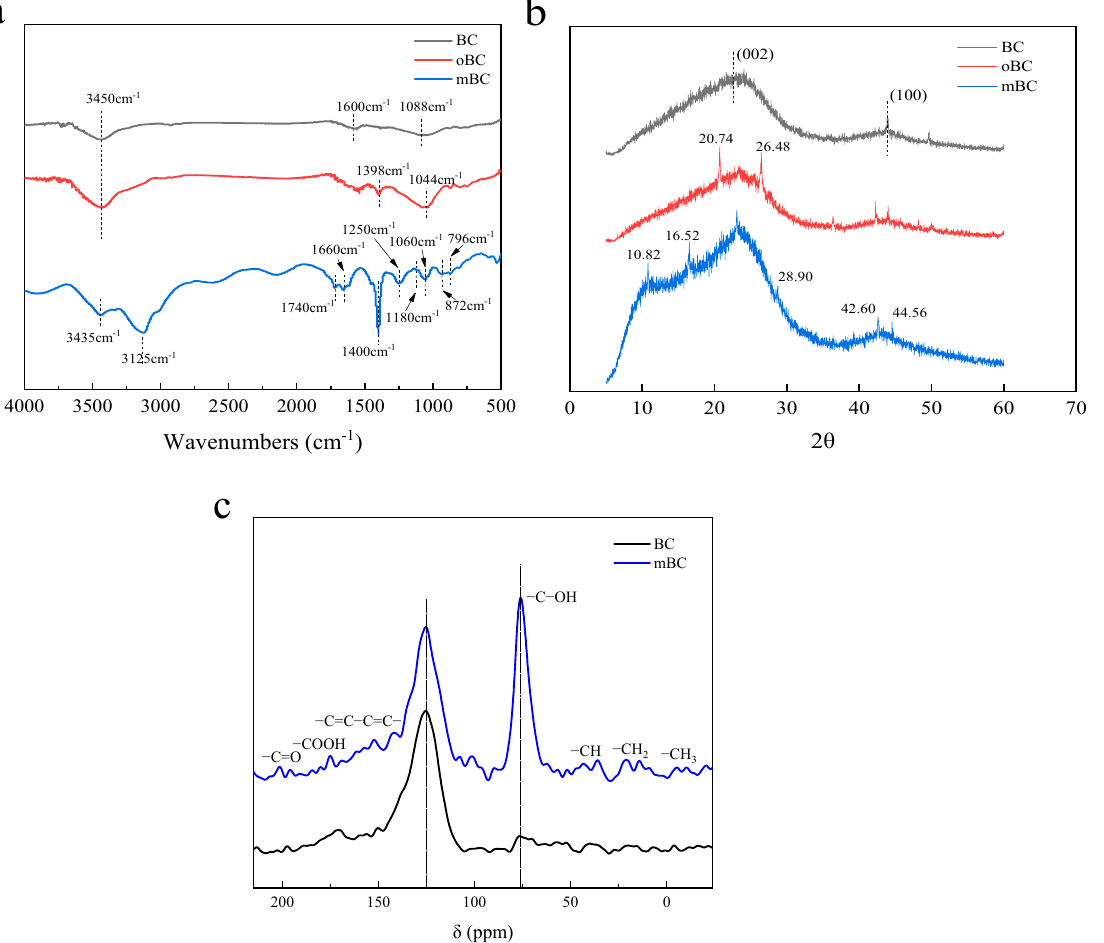
Figure 3. FTIR( a ), XRD( b ) and 13 C-NMR( c ) spectra of BC, oBC and mBC. Figure 3. FTIR ( a ), XRD ( b ) and 13 C-NMR ( c ) spectra of BC, oBC and mBC. XRD data were analyzed to further confirm the differences between virgin BC and Unlike virgin BC, the oxide BC gained obvious peaks at 2 θ = 20.74° and 26.48°, and mBC. Virgin BC did not claim any clear and definite diffraction peaks, as shown in Figure 3b, mBC had a good deal of crystal structures, for instance, peaks at 2 θ = 10.82°, 16.52°, 28.90°, merely representing the amorphous structure of carbon (biochar). The broad peaks at 42.60°, and 44.56°, respectively, which undoubtedly disclosed that the as-fabricated mBC 2 θ = 20 ◦ –30 ◦ generally denoted carbon reflection from the stacked hexagonally structured had produced new crystal structures through the coordinative modification of IP6 and graphite (002), and the weak peak around 2 θ = 43 ◦ revealed that pyrolytic carbon was urea; these structures were homologous to the traditional polyphosphate-based flame re- derived from the hexagonal structure tardants, which could be deemed solid proof of the grafting to the BC surface.